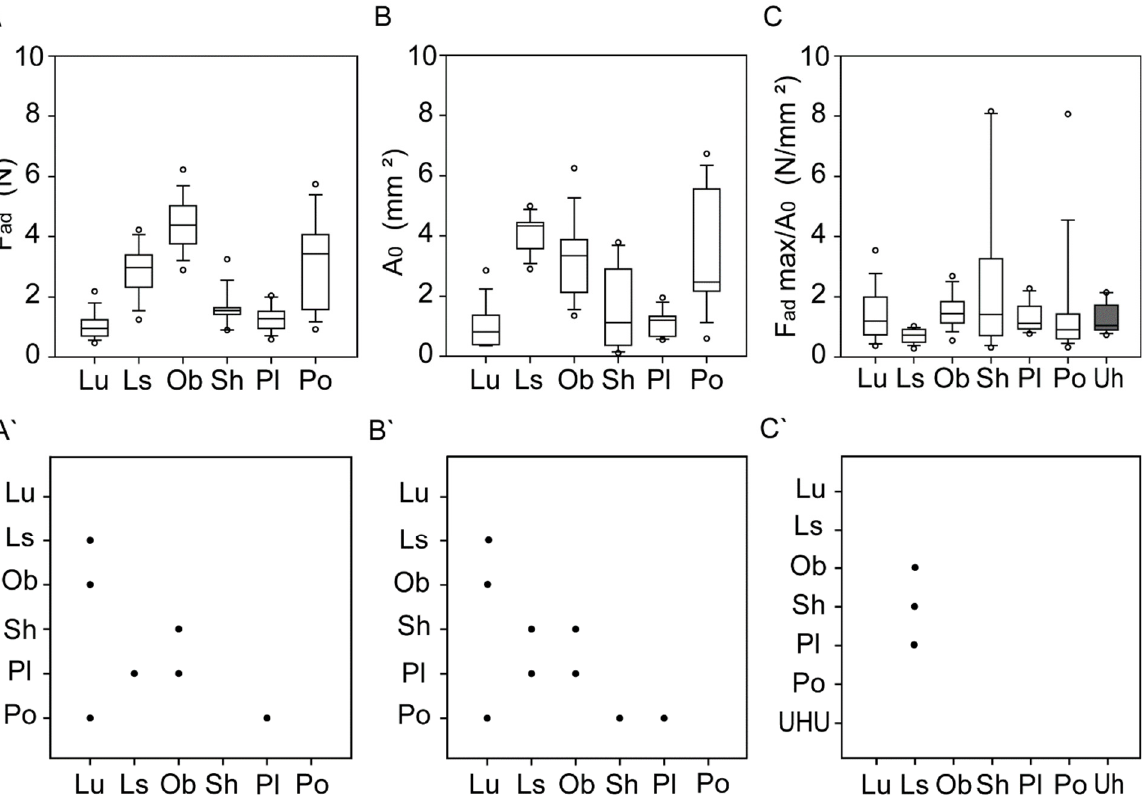
Figure 3. (A – C ) Adhesion force ( A ), contact area ( B ) and adhesive strength ( C ) of the seed mucilage dried out in contact. ( A’ – C’ ) Multiple comparison graphs of the adhesion force ( A’ ), contact area ( B’ ) and strength force ( C’ ) of the seed muci-